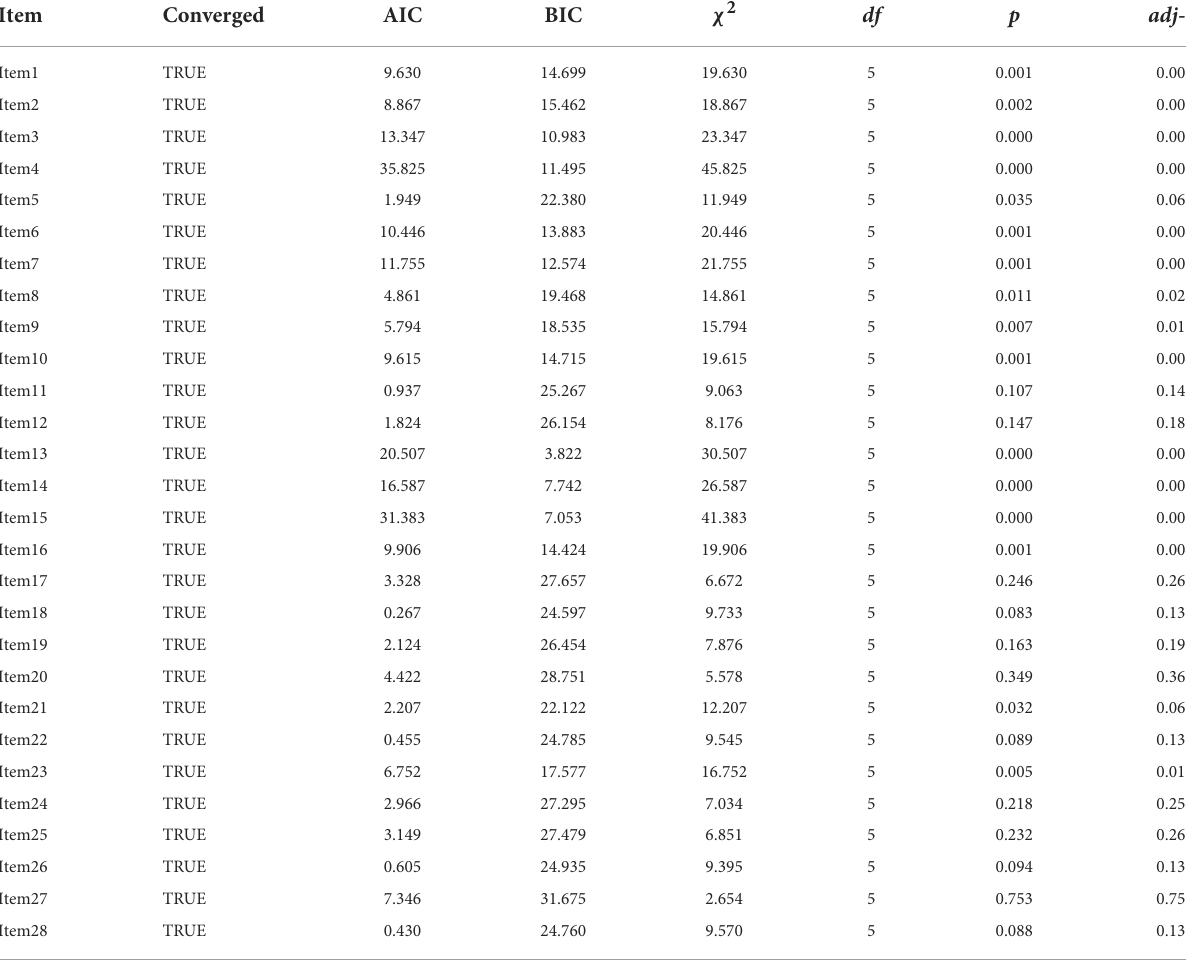
TABLE 4 Gender differential item functioning.